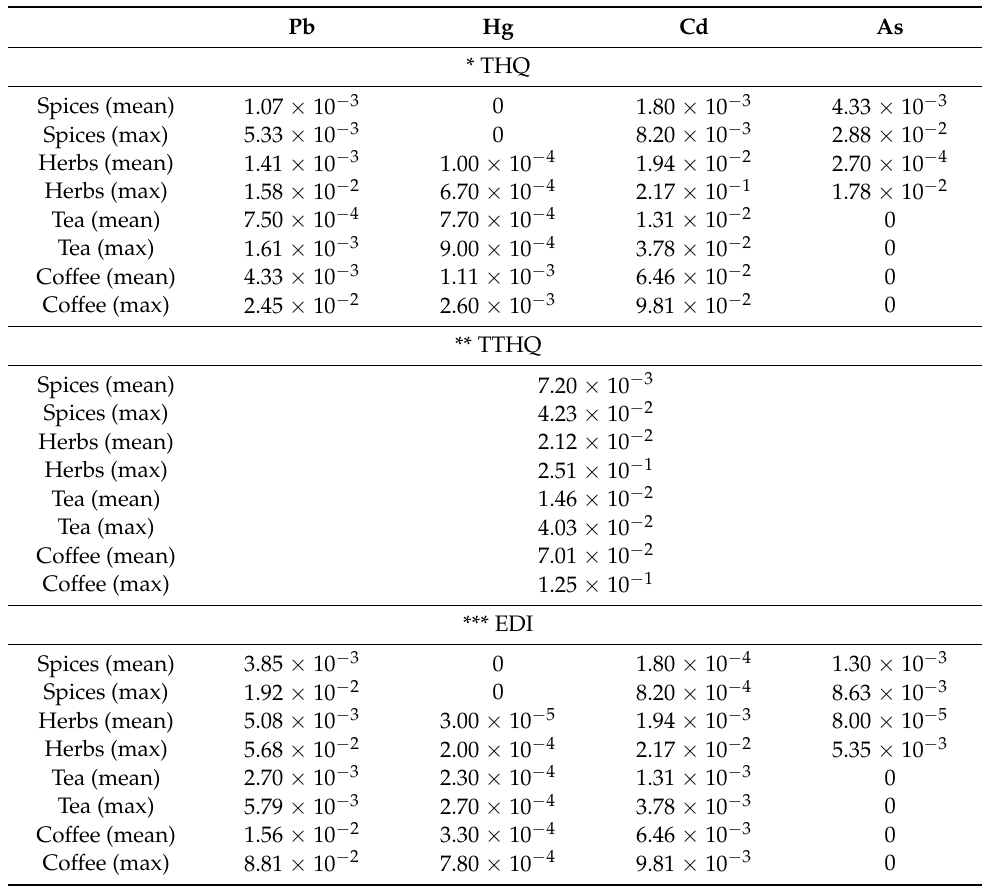
* THQ—target hazard quotient; ** TTHQ—total target hazard quotient; *** EDI—estimated daily intake. CR values of As were from 0 (tea and coffee mean value of As) to 1.95 × 10 − 6 (spices